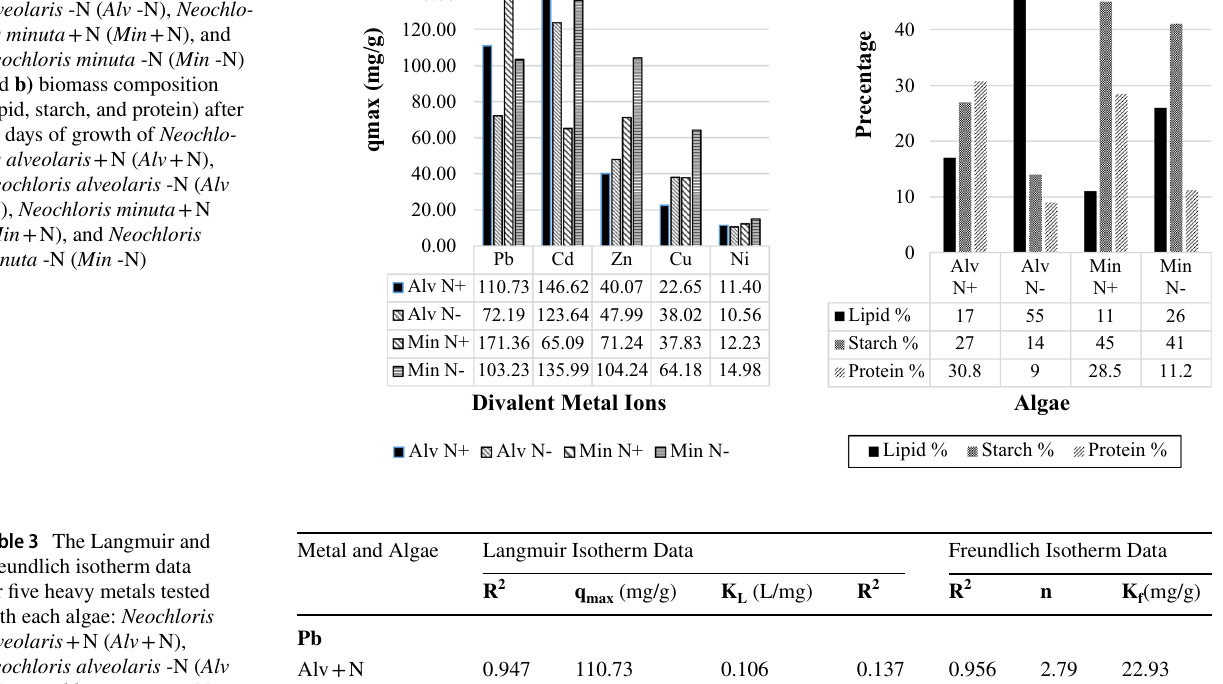
Fig. 16 a) Bar graphs of the Langmuir isotherm biosorption capacities (q max ) of five metal ions for Neochloris alveola- ris + N ( Alv + N), Neochloris alveolaris -N ( Alv -N), Neochlo- ris minuta + N ( Min + N), and Neochloris minuta -N ( Min -N) and b) biomass composition (lipid, starch, and protein) after 10 days of growth of Neochlo- ris alveolaris + N ( Alv + N), Neochloris alveolaris -N ( Alv -N), Neochloris minuta + N